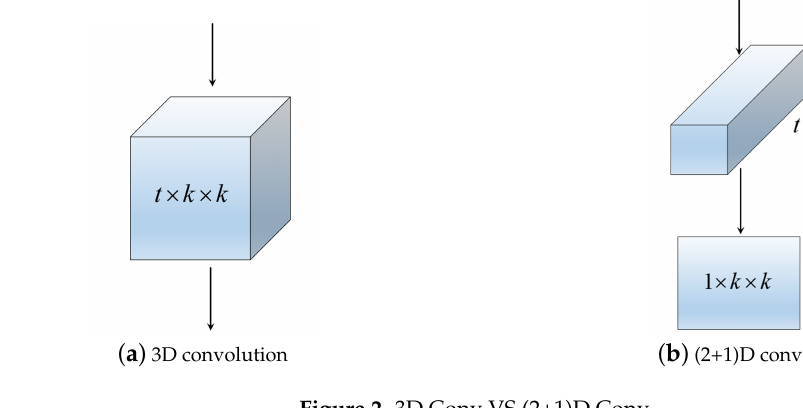
Figure 2. 3D Conv VS (2+1)D Conv.